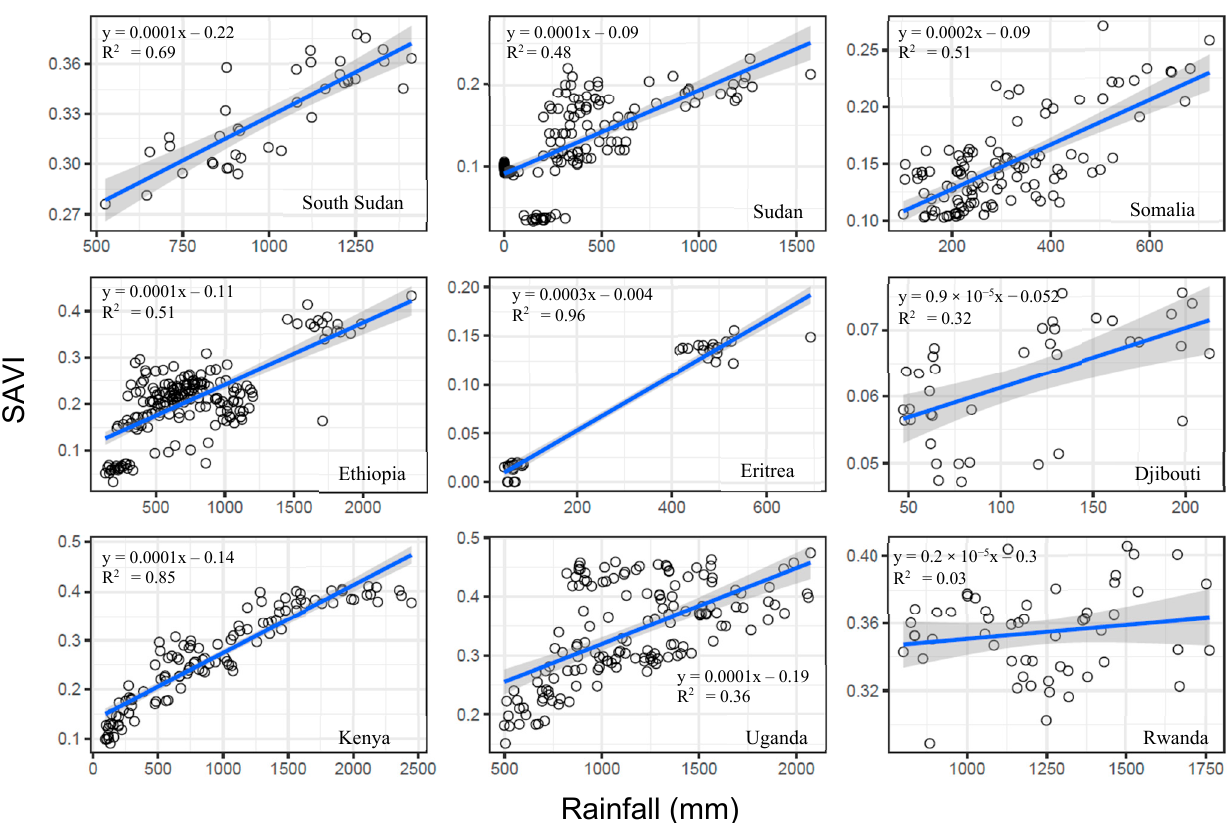
Figure 5. Relationship between SAVI and Rainfall (2001-2019) in the studied countries.